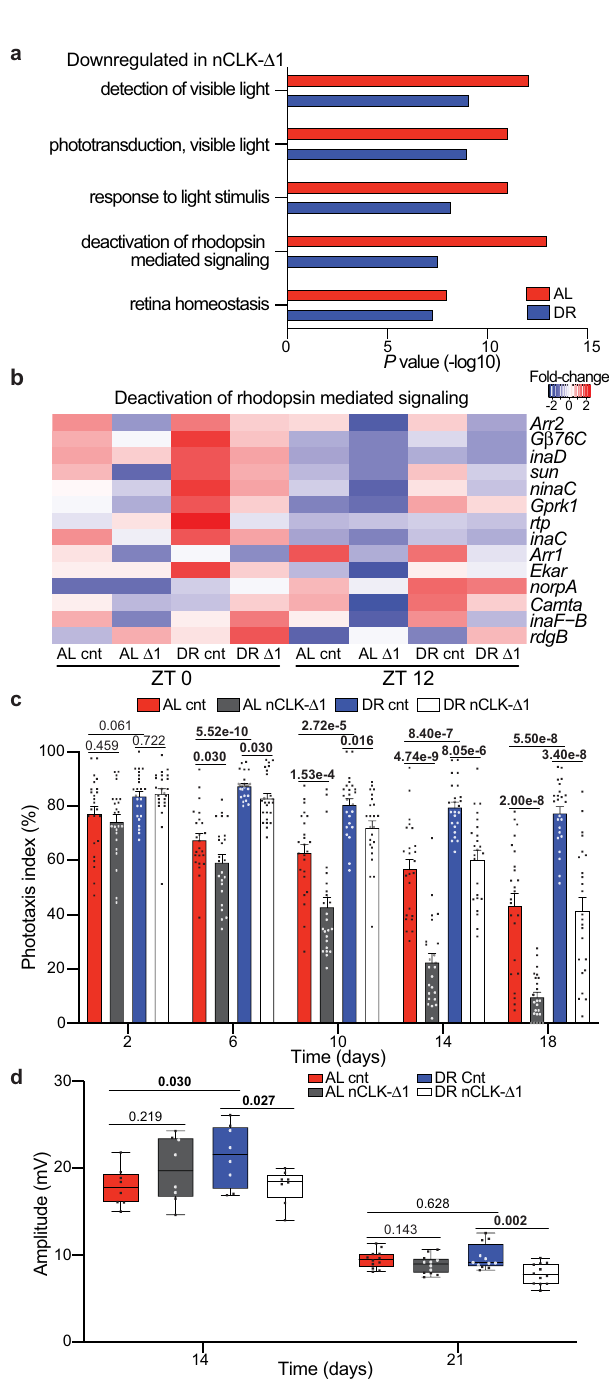
cannot solely be attributed to diet-dependent changes in